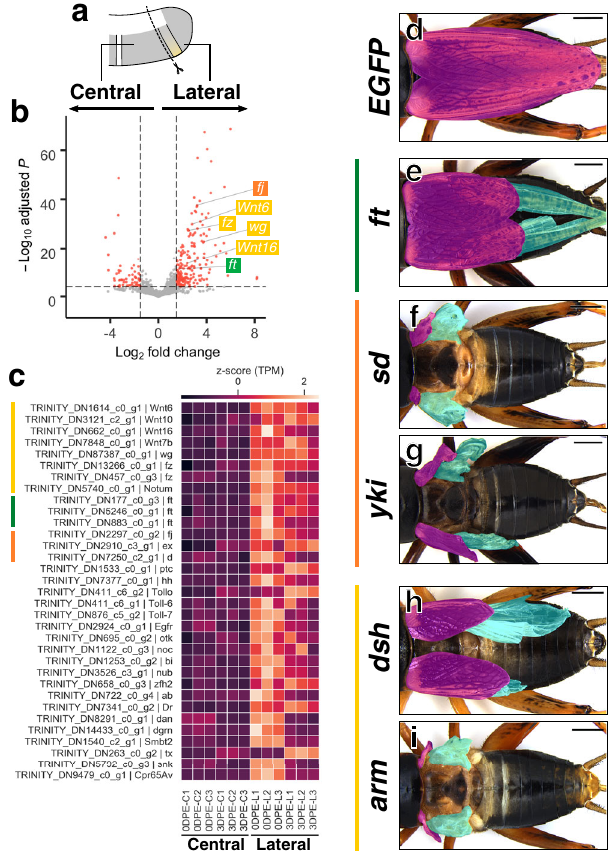
Fig. 4 Wnt, Ft-Ds and Hippo signaling are required for the postembryonic wing growth in Gryllus . a Schematics illustrates tergal regions used for the transcriptome comparison. Note that only T2 and T3 segments were used for this analysis. b A volcano plot shows differential expression of transcripts between central and lateral regions in T2 and T3 terga. Data after log-fold change shrinkage with the apeglm method is visualized. Signi fi cantly differentially expressed transcripts (adjusted P < 10e − 5, fold change >1.5) are in red. A Wald test was used for signi fi cance testing and P values were adjusted using the Benjamini and Hocheberg method according to DESeq2 software. Some representative transcripts that are highly expressed in the lateral region are labeled. c Heatmap indicating expression level of 33 candidate genes in each sample. Color code indicates z -score normalized transcripts per million (TPM). d – i Adult phenotypes after nymphal RNAi treatment. Fore- and hindwings are shaded in magenta and cyan, respectively. Scale bars are 2